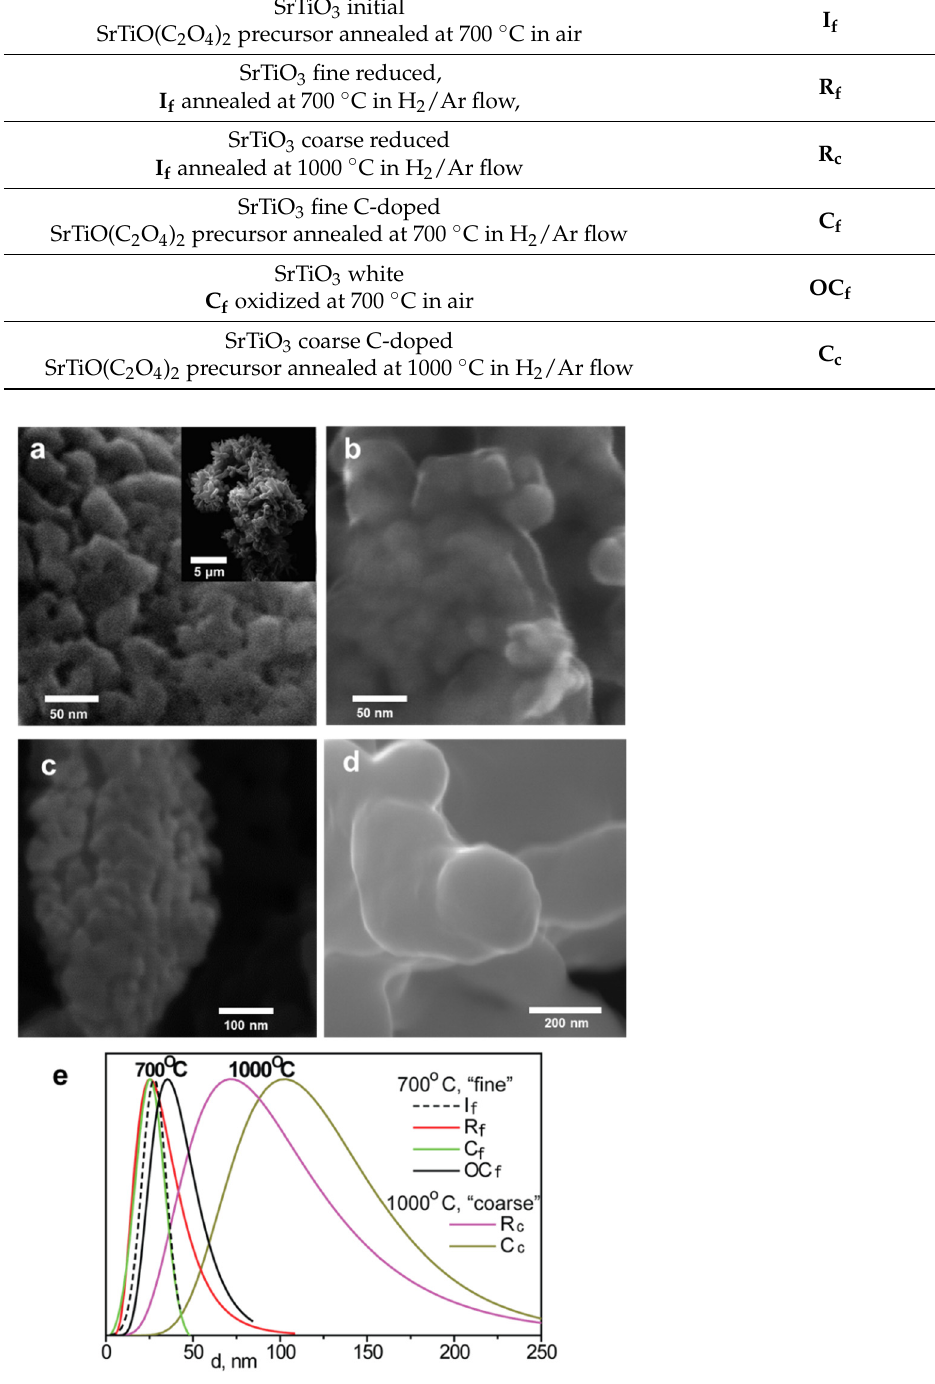
Figure 3. SEM image of ( a ) C f nanoparticles and their as-grown aggregates (inset), ( b ) R f , ( c ) OC f, and ( d ) C c nanoparticles. ( e ) Particle size distributions for fine and coarse nanopowders. Table 2. Lattice constant a and particle size derived from XRD and SEM